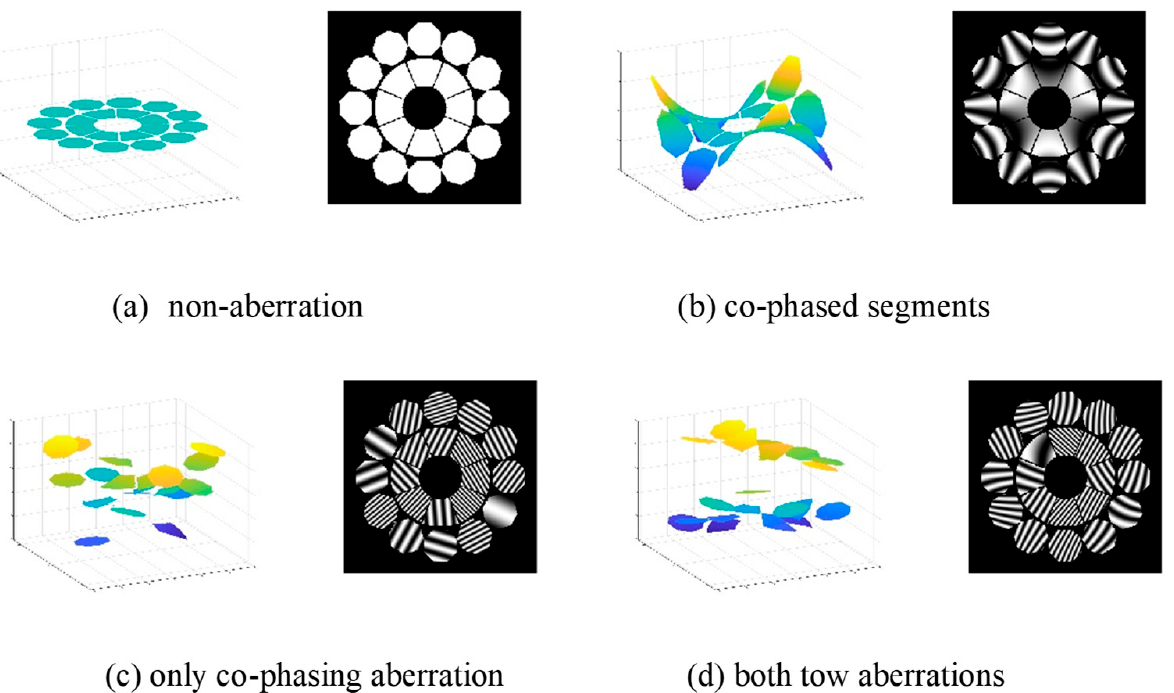
Figure 2. Simulated image of the profile function 𝜔(x, y) , ( a ) with no aberration, ( b ) with system aberration of RMS = 240 nm in the case of segments, ( c ) with co-phasing aberration, piston < 0.01 mm and tip/tilt < 0.01 rad, and ( d ) with both aberrations of ( b , c ). Based on the phase-shifting and multiwavelength methods previously discussed, the profile function 𝜔(x, y) expressed by Equation (11) can be calculated. A mask with sev- (𝑥, 𝑦) as a circle for the requirement eral holes was applied to limit the pupil function 𝐶 (cid:3036) of using Zernike polynomial to fit the wavefront.